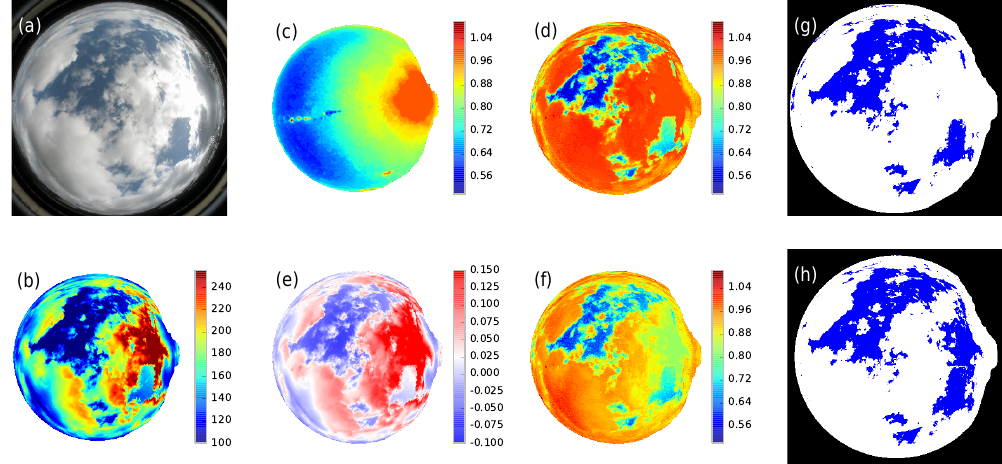
Figure 3. Cloud detection. (a) Original image, (b) pixel intensity, (c) RBR clear sky reference, (d) RBR without correction, (e) absolute RBR correction, (f) RBR with correction, (g) binary cloud map without correction, and (h) binary cloud map with